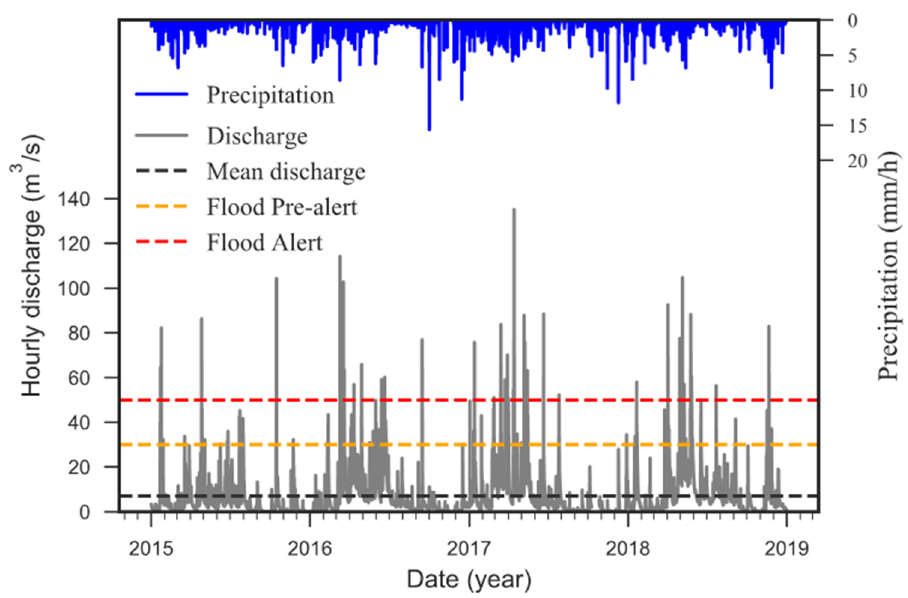
Figure 2. Time series of precipitation (Toreadora) and discharge (Matadero-Sayausí). Horizontal dashed lines indicate the mean runoff and the currently employed flood alert levels for labeling the Pre-alert and Alert flood warnings classes.